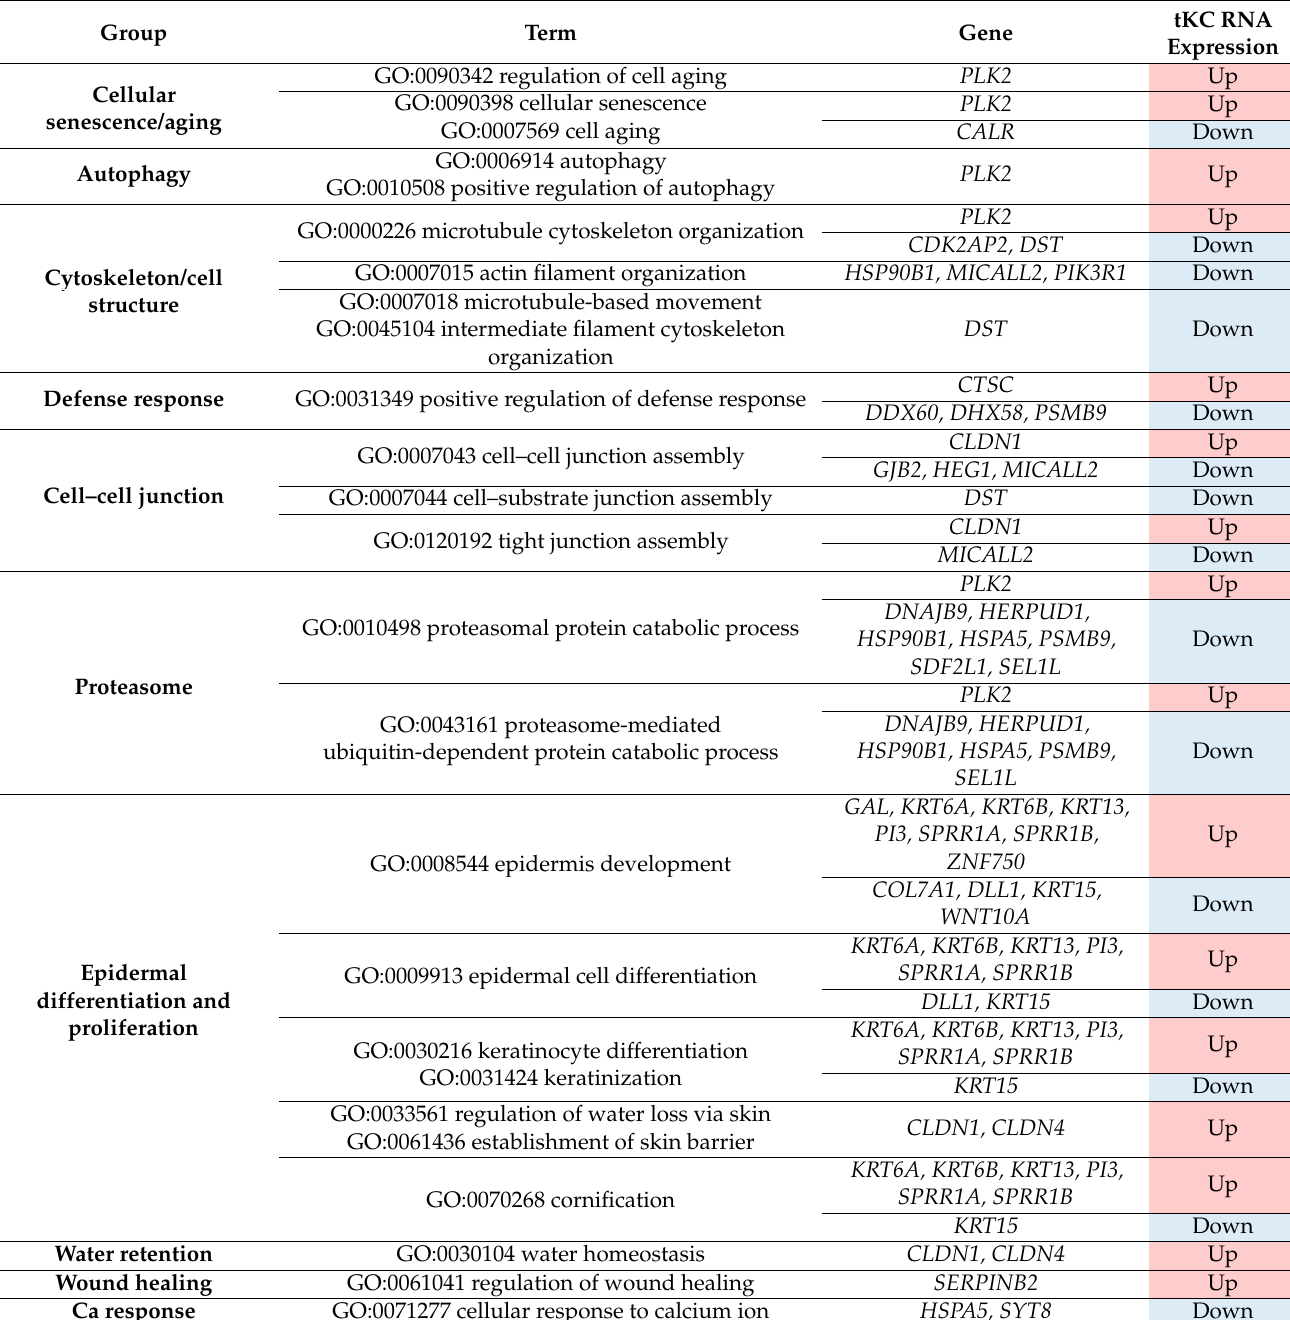
Table 3. Gene ontology of skin-related genes up- and downregulated by